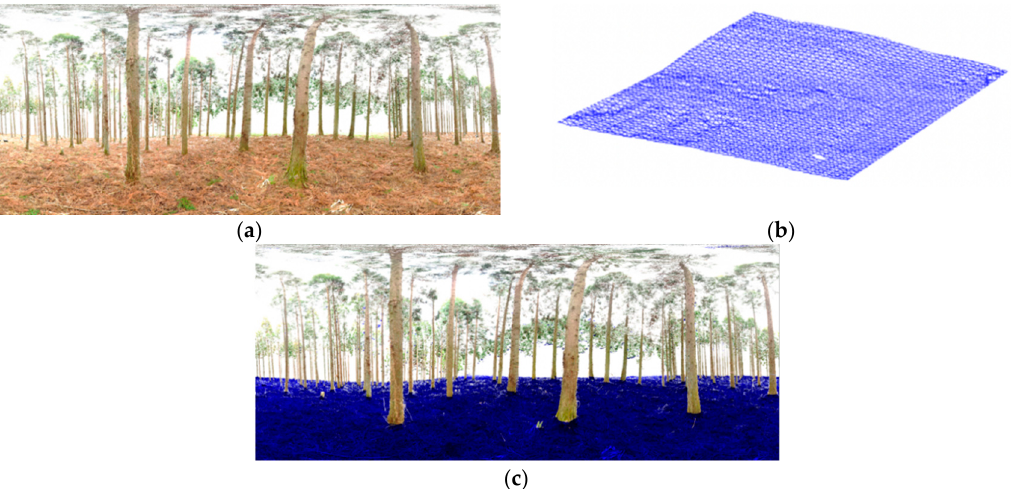
Figure 5. Removal of points on the ground. ( a ) Example of a point cloud in a test site; ( b ) digital terrain model (DTM); ( c ) points of trees after removing ones on the ground (navy blue).